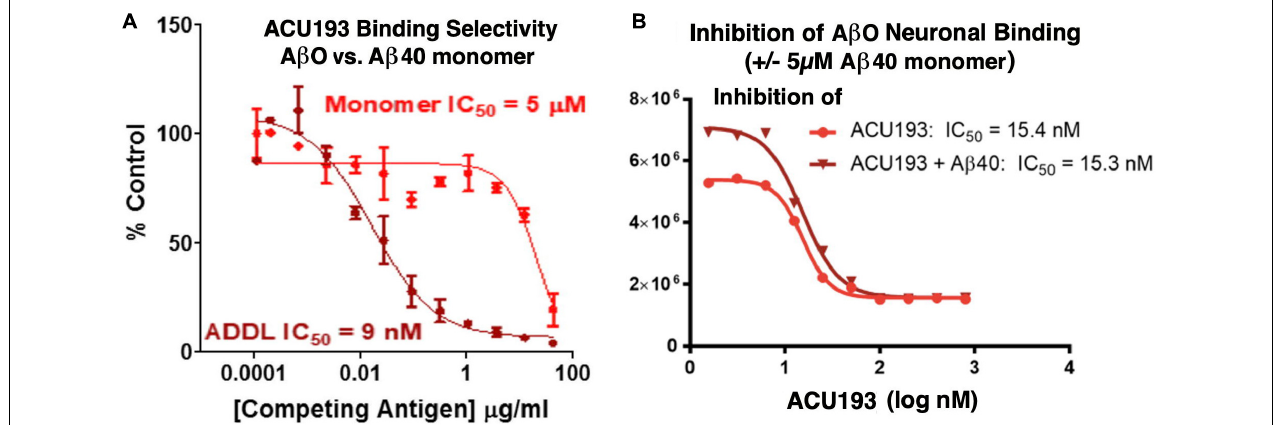
FIGURE 3 | (A) Competitive ELISA for ACU193 binding to A β O or monomeric A β 40 (Savage et al., 2014); (B) binding affinity of ACU193 to A β Os does not change significantly when 5 µ M monomeric A β 40 is added to the cell culture medium. These results support the conclusion that selectivity of ACU193 for A β Os